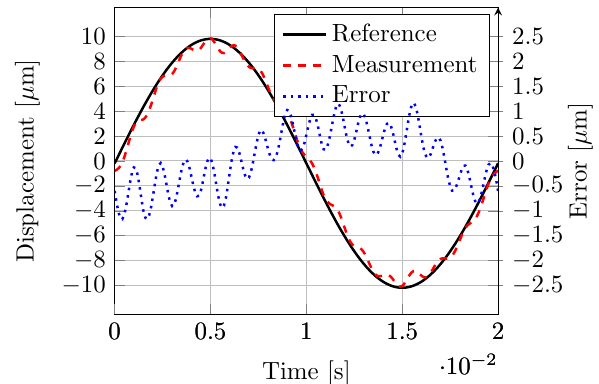
Figure 10: A too low discretization level, n h = 10, on the Preisach model causing the hysteresis compensation to not be sufficient.